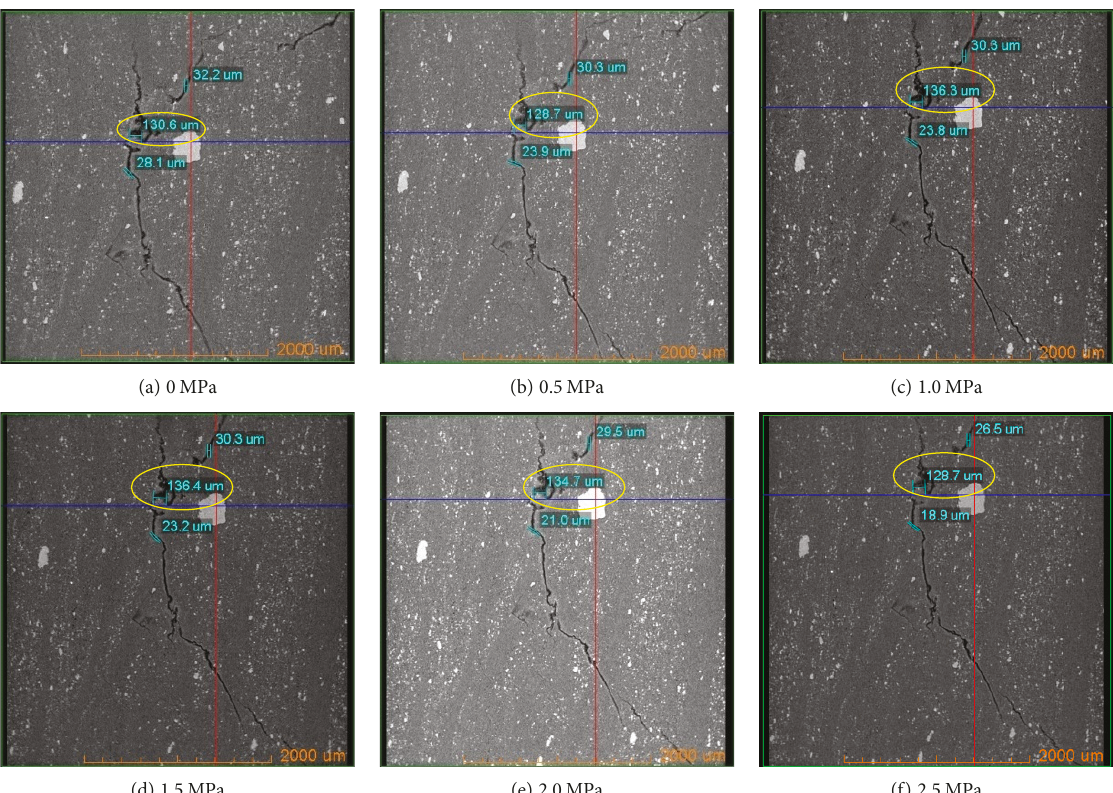
Figure 9: CT images of fracture size (xz